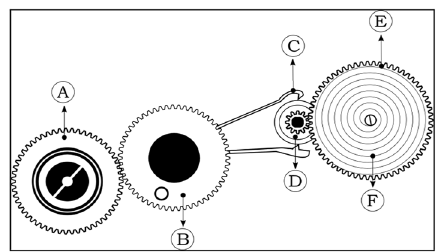
Fig. 1 Winding gear train of SEIKO7S26A Caliber. A The oscillating weight or the rotor, B First reduction wheel, C Pawl Lever, D Second Reduction wheel, E Ratchet Wheel, F Mainspring, contained in the barrel (attached to the Ratchet Wheel)